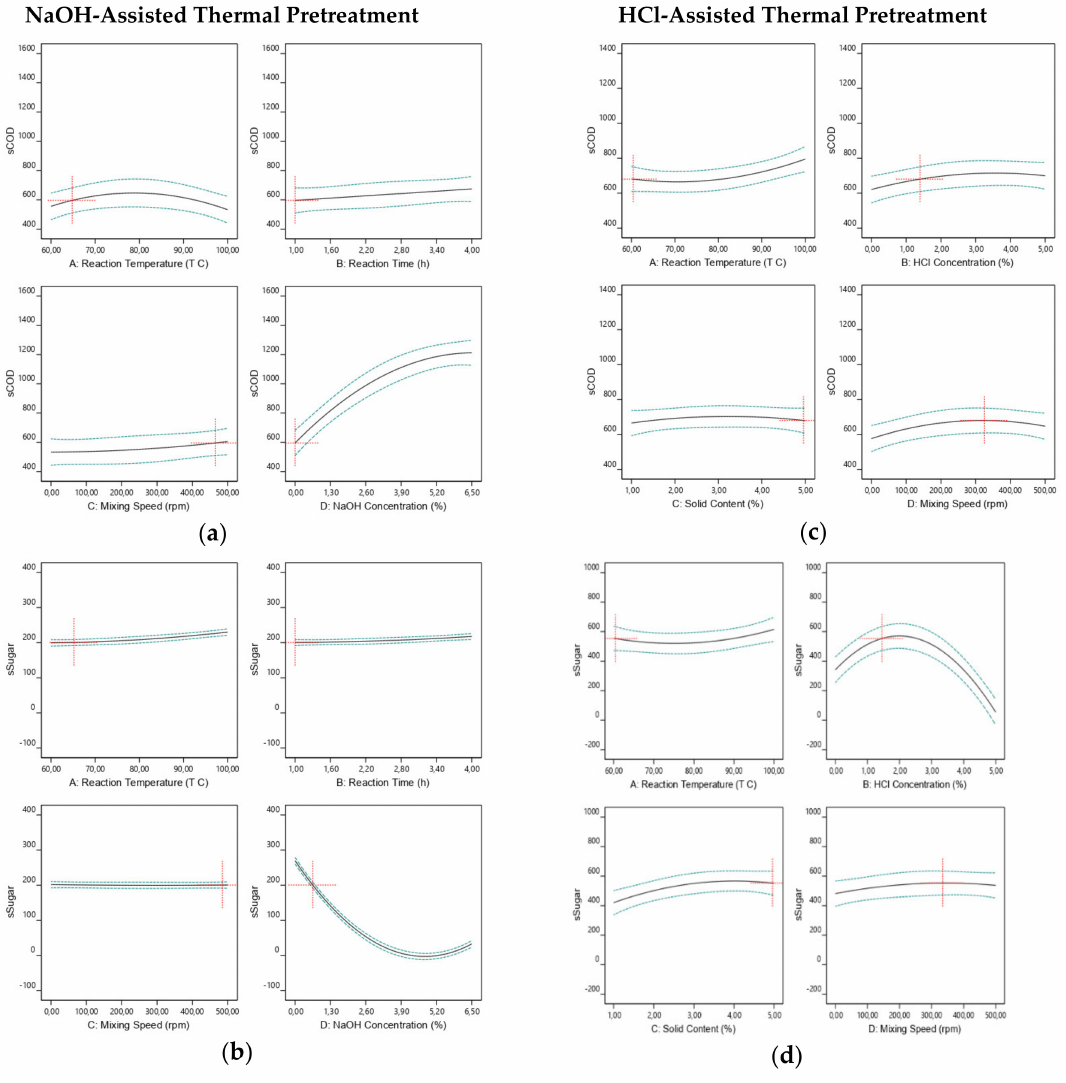
Figure 2. Individual impacts of independent variables (Reaction temperature, reaction time, mixing speed and NaOH concentration) on sCOD ( a ) and sSugar ( b ) of NaOH-assisted thermal pretreatment; individual impacts of independent variables (Reaction temperature, HCl concentration, solid content and mixing speed) on sCOD ( c ) and sSugar ( d ) of HCl-assisted thermal